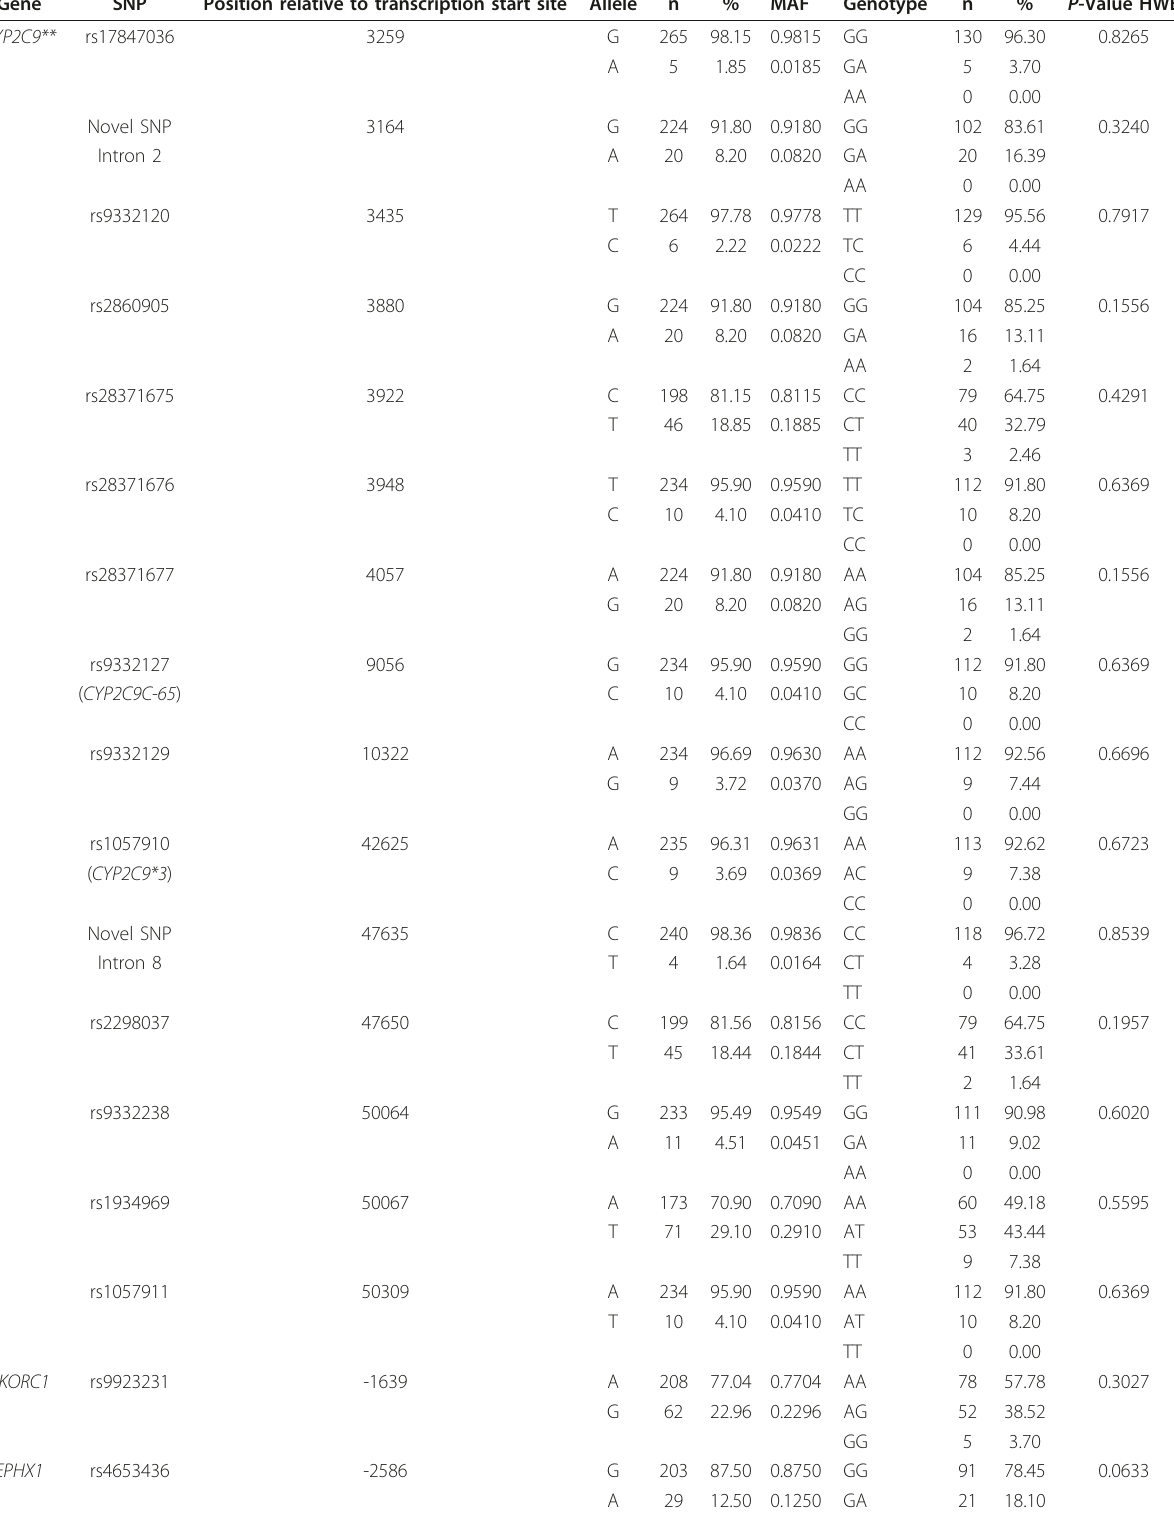
Table 2 Allele frequencies and genotype distribution of SNPs evaluated in this study Gene